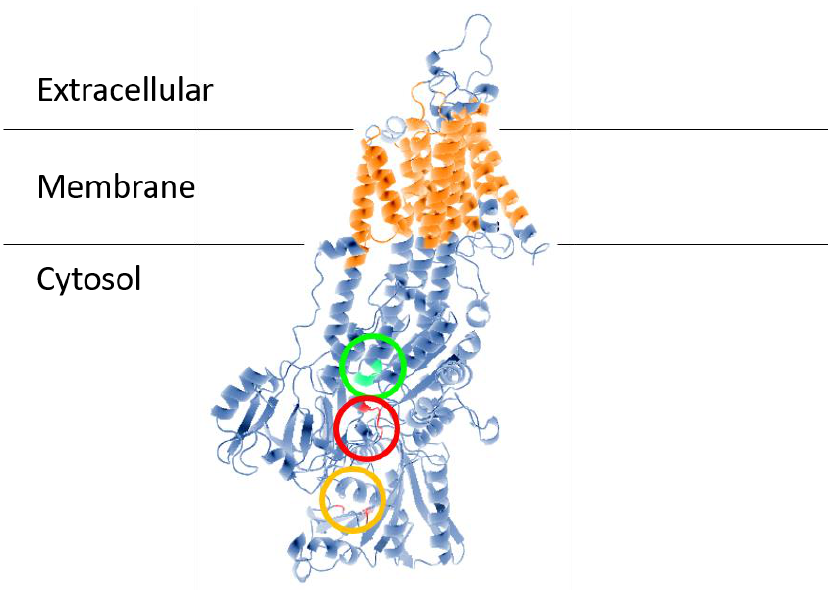
Figure 1. Structural model of ENA ATPase from T. cruzi (TcENA). The model was constructed using the protein structure prediction PHYRE (www.sbg.bio.ic.ac.uk/phyre/) [26], based on the model of the SERCA ATPase and visualized with the standard molecular viewer PyMOL 2002 (DeLano, W.L. The PyMOL Molecular Graphics System, DeLano Scientific, San Carlos, CA, USA; http://pymol.sourceforge.net/). The 10 transmembrane helices are shown in orange, and the key residues mentioned in the text are highlighted by a red circle (conserved TGEA domain), an orange circle (F 480 , K 485 , K 504 residues related to nucleotide binding); and a green circle (DGFND 700 domain involved in Mg 2+ binding).